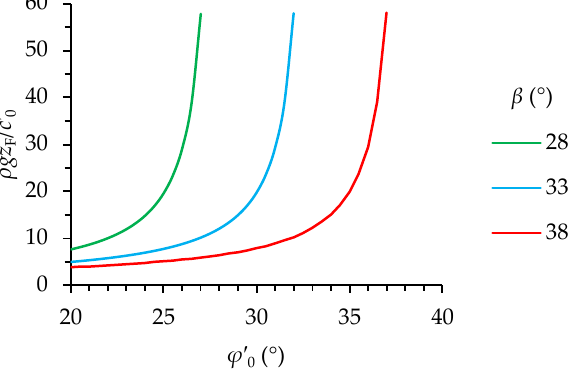
Figure 7. The dimensionless depth of the slip surface ρgz F / c ′ 0 as a function of the soil friction angle φ ′ 0 and the slope angle β .